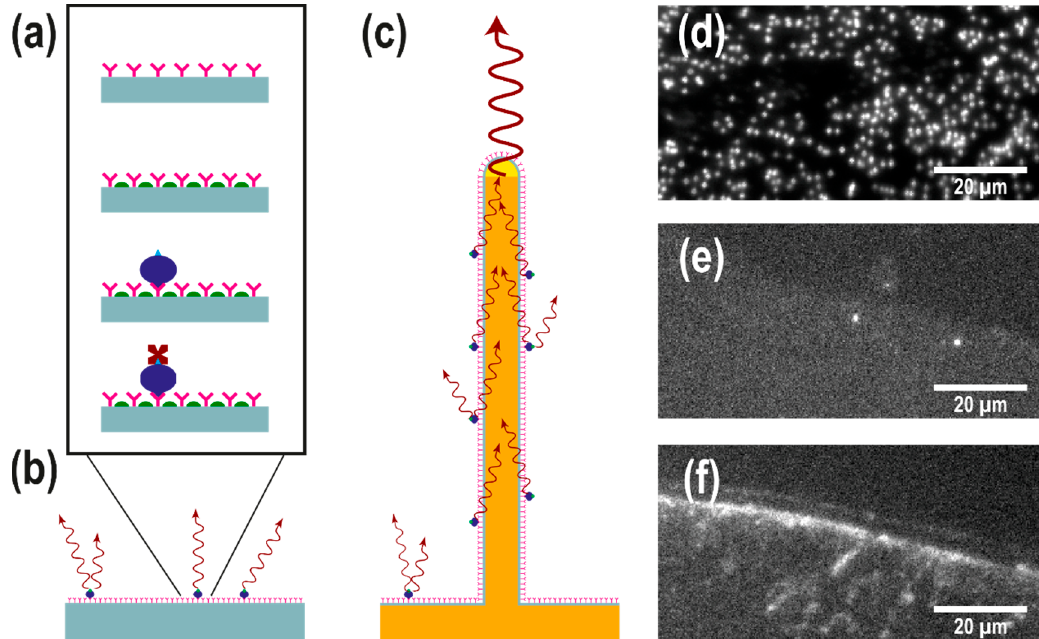
Figure 2. ( a ) Schematic representation of the single chain fragment variable (scFv) assay used in this study. ScFv antibodies (pink) are physisorbed on a surface. A blocking agent (green) is subsequently used to minimize unspecific binding of biotinylated serum proteins (blue), which are targeted by fluorescently labelled streptavidin (dark red). ( b , c ) Schematic representation of the assay on a flat substrate ( b ) and a light-guiding nanowire substrate ( c ): the emission of fluorophores on the nanowire surface excites the supported waveguide modes to be reemitted at the tip, leading to an enhanced signal intensity at the tip of the nanowires. ( d – f ) Top-view epifluorescence images (displayed in the same pixel window) of ( d ) a GaP nanowire substrate, ( e ) a silicon substrate and ( f ) a MaxiSorp black polymer substrate, spotted with antibodies and exposed biotinylated serum concentration diluted to 0.4% (the highest concentration used in this study). Individual nanowires are visible in ( d ) as bright spots. The edge of the scFv spot is visible in ( e , f ), showing the difference in the signal between specific an unspecific binding to the antibodies.